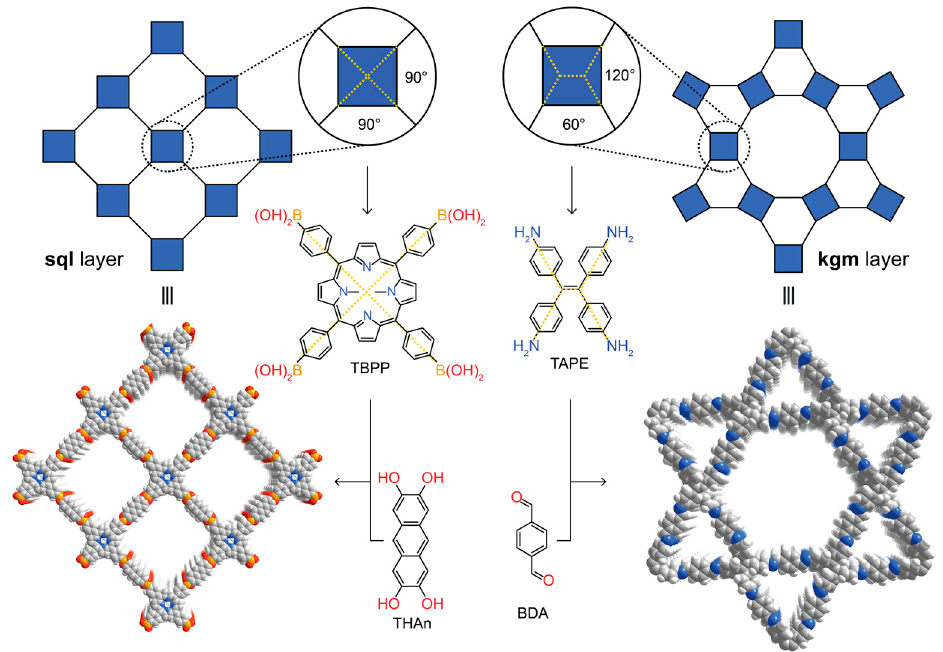
Figure 2. Targeted reticular retrosynthesis of covalent organic frameworks with different topologies but with the same connectivity. Precise adjustment of the angles in the starting materials yields covalent organic frameworks (COFs) of square lattice (COF-66) or kagome topology (4PE-1P-COF).